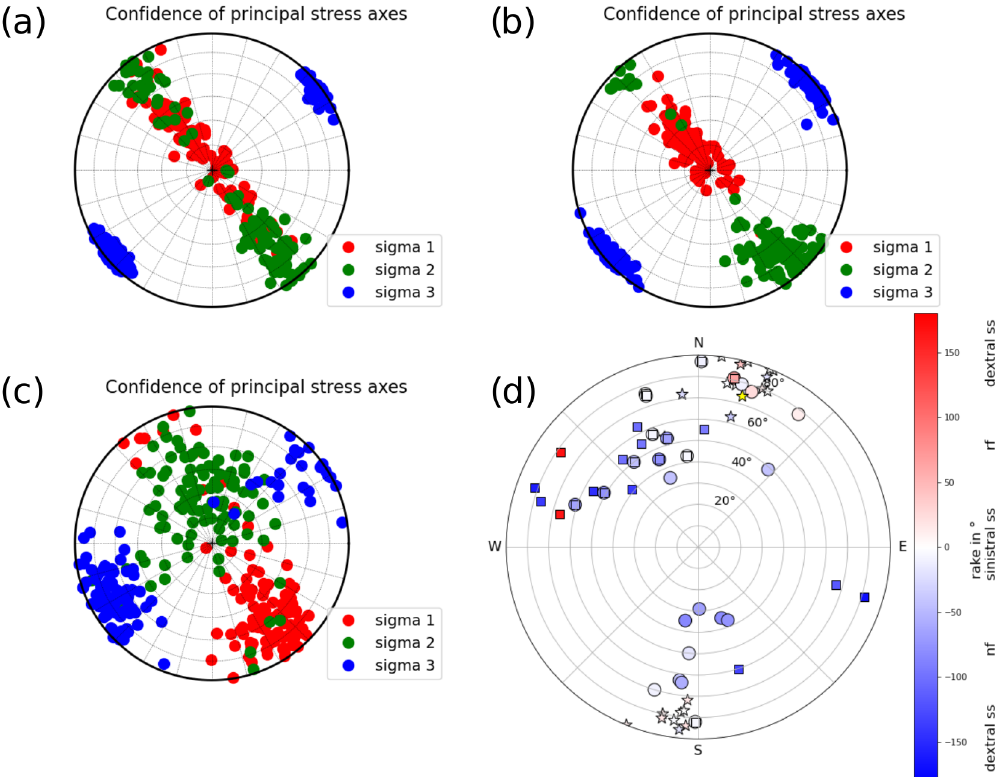
Figure 8. (a) Confidence plot of the principal stress axes σ 1 , σ 2 and σ 3 after the stress inversion of all fault plane solutions (Table 2) for the 100 different noise realizations. (b) The same as Fig. 8a but only for fault plane solutions with a depth greater than 7.5km. (c) The same as Fig. 8a but only for fault plane solutions with a depth less than 7.5km. (d) Strike, dip and rake of all measured fault plane solutions (circles). The yellow star represents strike and dip of the 22 March 2003 earthquake (Stange and Brüstle, 2005). Other stars represent fault plane solutions calculated by Turnovsky (1981) for the earthquake series in 1978. Fault planes of StressInverse (Vavryˇcuk, 2014) are displayed by squares. Negative rake angles hint at normal faulting (nf) components, and positive angles hint at reverse faulting (rf) components. Events with a rake close to zero exhibit sinistral strike-slip (sinistral ss) components; events with rake angles close to − 180 or 180 ◦ hint to dextral strike-slip (dextral